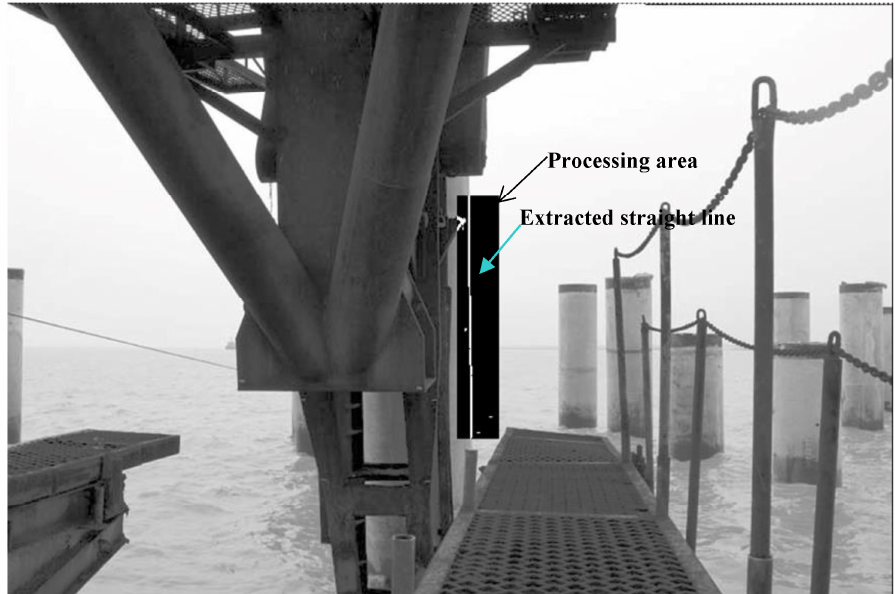
Figure 9. Image from the camera and extraction of the straight line of the pile edge.